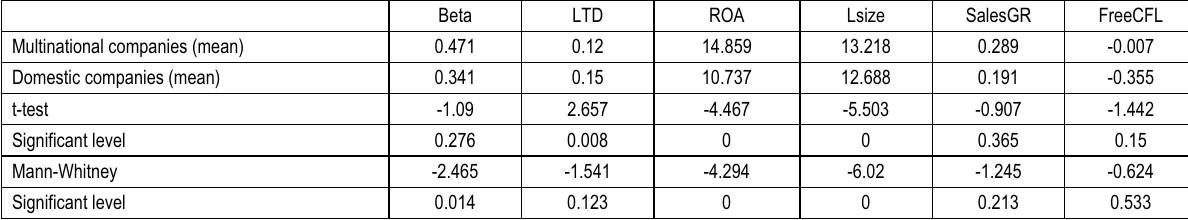
Table 4. Results of t and Mann-Whitney tests